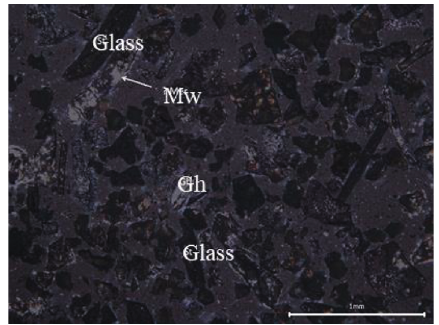
Figure 2: Microscopic image for GGBS.